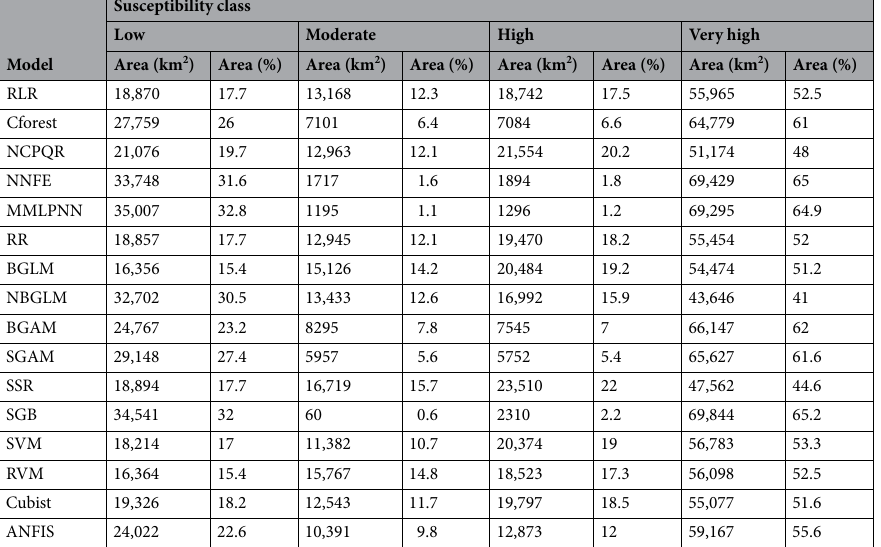
(Fig. 8b), calcium carbonate percentage (Fig. 8c), electrical conductivity (EC) (Fig. 8d), exchangeable sodium percentage (ESP)(Fig. 8e), organic carbon content (OCC)(Fig. 8f) and soil texture (Fig. 9a)) were extracted from